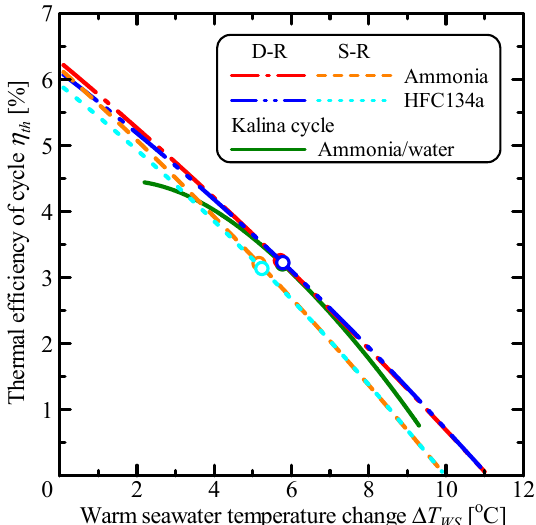
Figure 11. Relationship between the warm seawater temperature change and the thermal efficiency of the cycle.